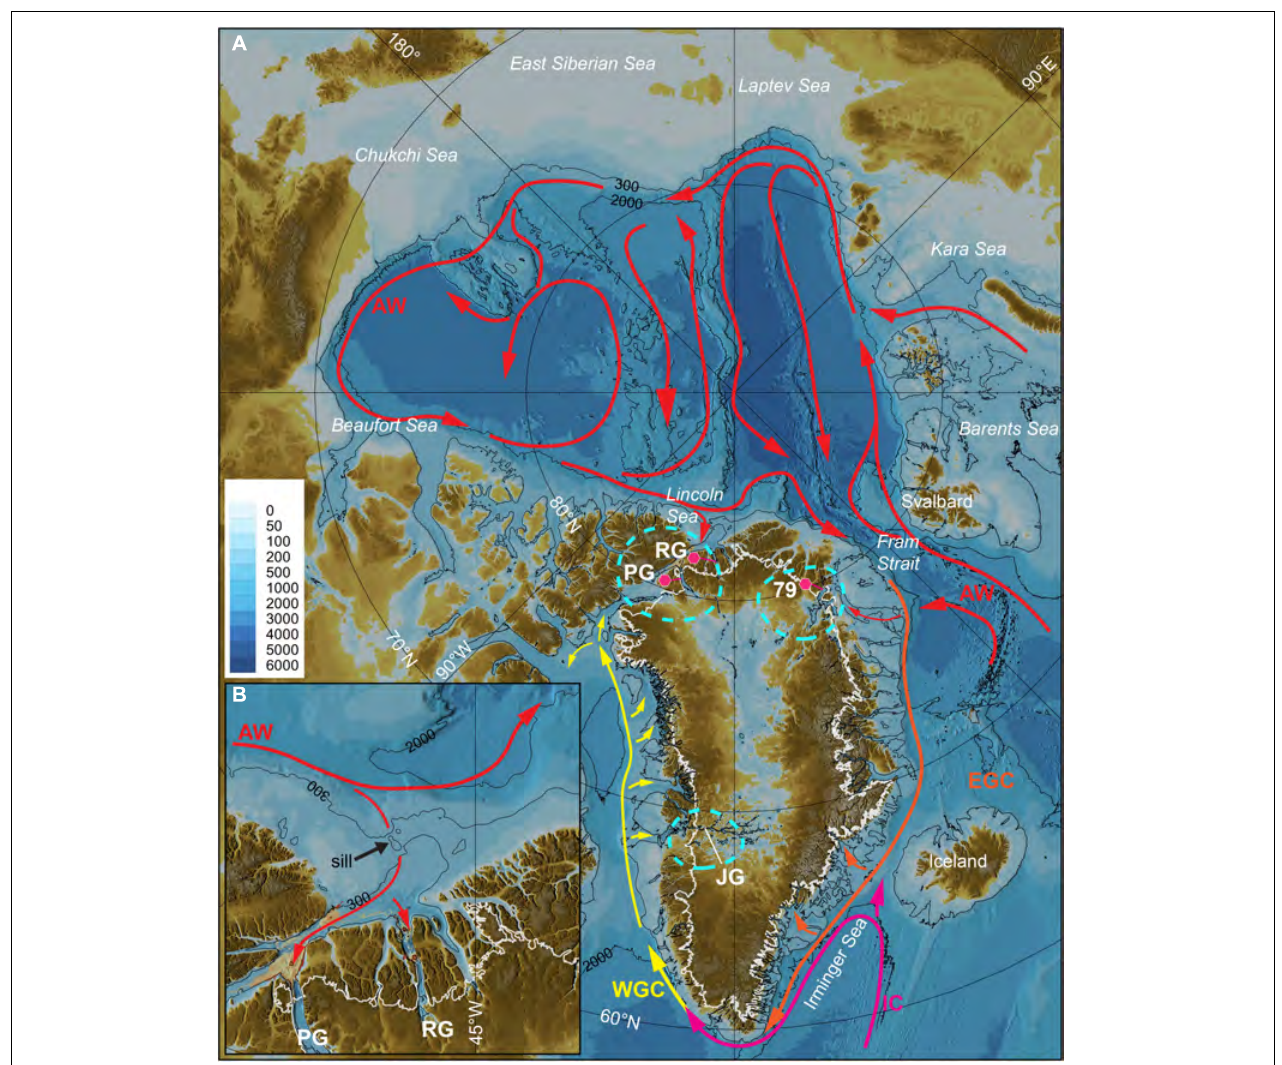
FIGURE 3 | Bathymetric map of the Arctic Ocean based on the International Bathymetric Chart of the Arctic Ocean (IBCAO) Version 4 (Jakobsson et al., 2020a). The under-ice topography in IBCAO Version 4 is based on BedMachine V3 (Morlighem et al., 2017). (A) Circulation of key water masses with respect to transport of warmer subsurface water toward marine outlet glaciers draining the Greenland Ice Sheet: Atlantic Water (red: AW), Irminger Current (purple: IC), East Greenland Current (orange: EGC) and West Greenland Current (yellow: WGC) (currents are inferred from: Rudels et al., 2012; Lin et al., 2018). Examples of where these warmer waters have been found to flow toward marine outlet glaciers are taken from Schaffer et al. (2017) (79 ◦ N Glacier), Khazendar et al. (2019) (Greenland west coast including Jakobshavn Glacier), and (Fenty et al., 2016) (all around Greenland). The three main “marine sections” of the Greenland Ice Sheet (white line shows ice-sheet extent) are encircled with a blue stippled line. Within these, the ice sheet has pressed the underlying bedrock below sea level implying an increased sensitivity with respect to ice-ocean interaction. The purple hexagonal symbols indicate remaining larger ice tongues. PG = Petermann Glacier; RG = Ryder Glacier; 79 = 79 ◦ North Glacier; JG = Jakobshavn Glacier. (B) Close up on North Greenland. The multibeam bathymetry collected in Petermann Fjord and Sherard Osborn Fjord is shown with rainbow color table (see Figure 4 for a full display). The 300 m depth contour in the Lincoln Sea indicate where there is a bathymetric sill influencing the general inflow of AW toward outlet glacier of North